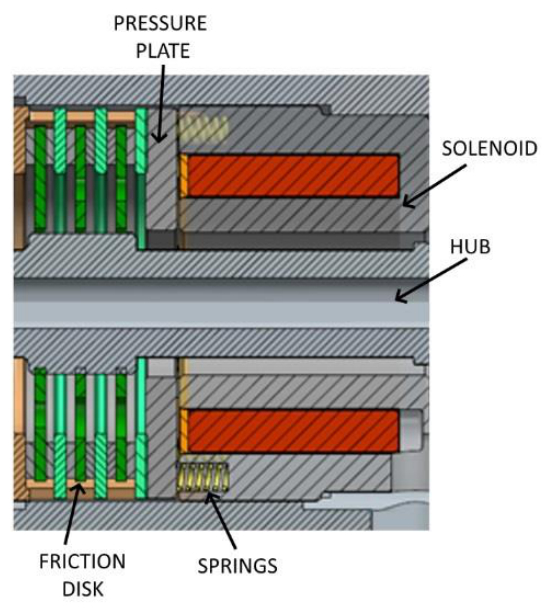
Figure 10. Electromagnetic power-off brake with clutch disk.